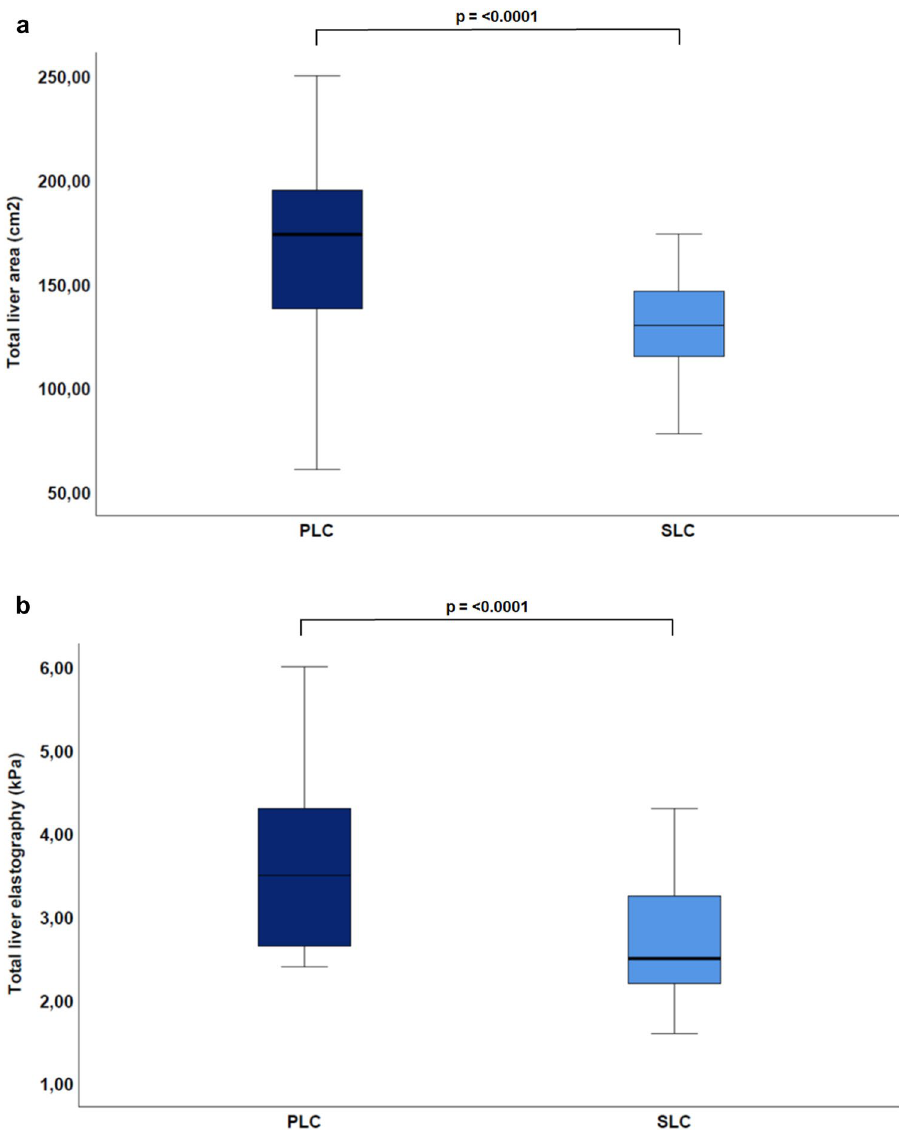
Figure 5. Comparison of PLC vs. SLC total liver ( a ) area (PLC: 166 ± 42.9 cm 2 vs. SLC: 130 ± 23.3 cm 2